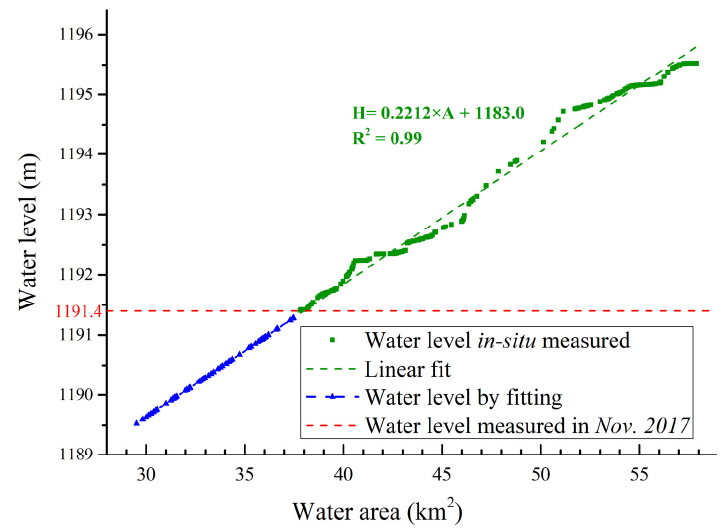
Figure 4. Relationship between the water level of HN and its lake area.